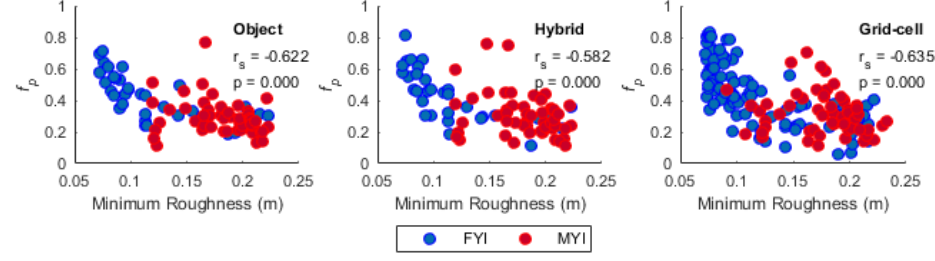
Figure 11. Scatter plots of f p as a function of smoothed minimum surface roughness at the medium scale using object ( left ), hybrid object ( middle ) and 240 m grid-cell ( right ) aggregation approaches. Spearman correlation coefficients (r s ) and corresponding p -values are shown for pooled FYI and MYI